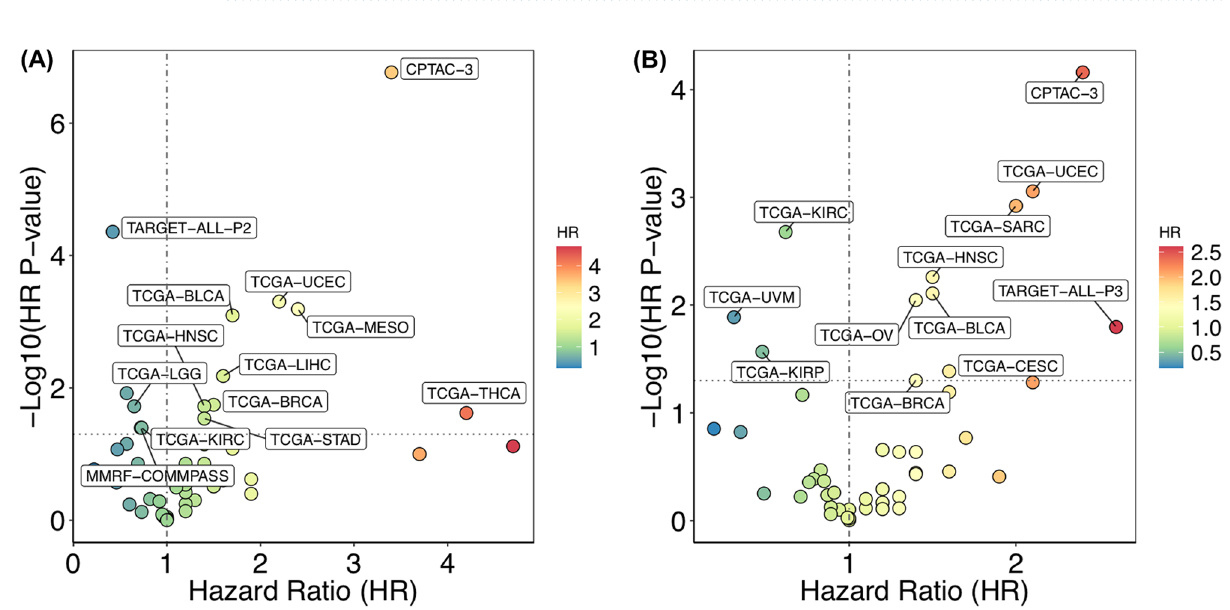
Figure 6. Gene ratio-based survival analysis. Association of ( A ) LAYN: GZMA and ( B ) LAYN: IFNG gene ratios on patient survival in different types of cancer. Only the significantly associated cancer types are